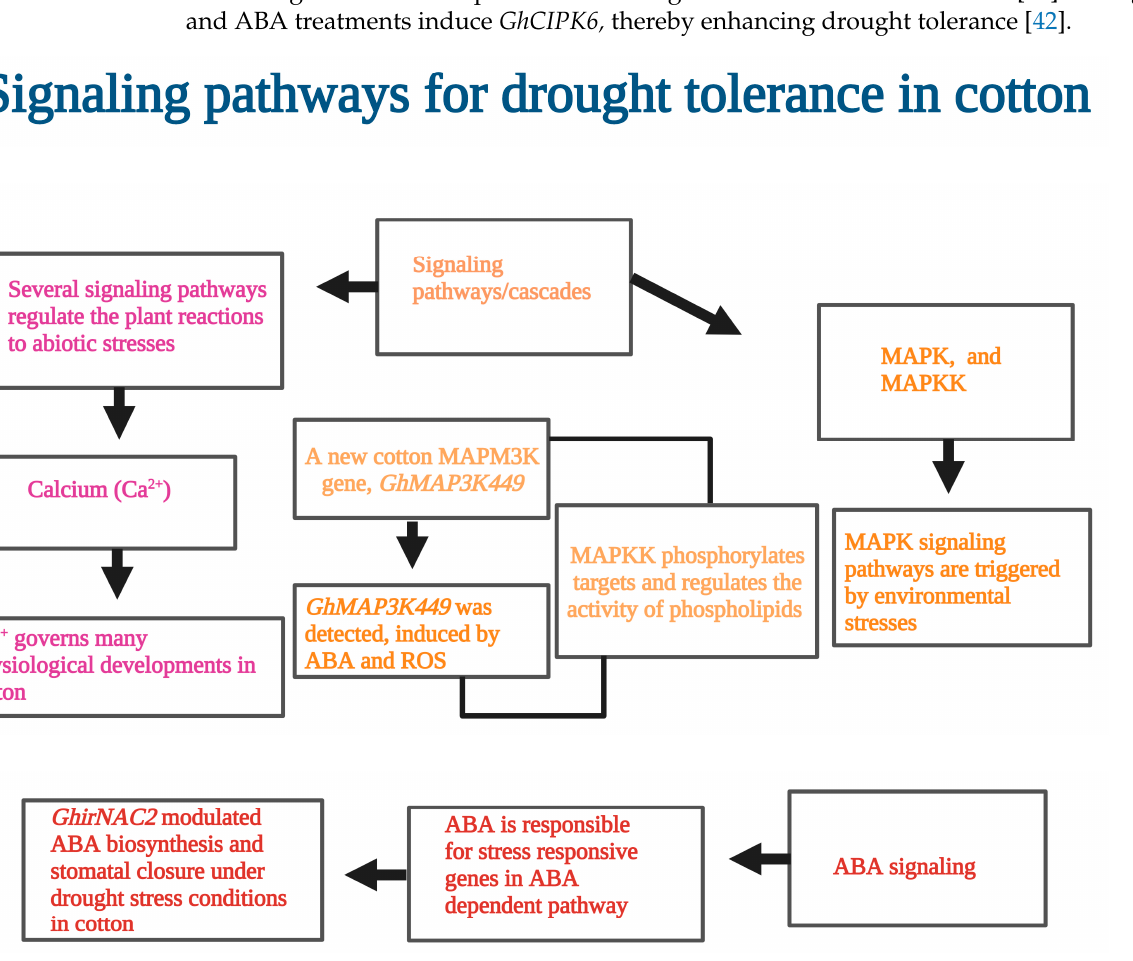
Figure 2. Drought tolerance is regulated by numerous genes and their interacting networks. MAPK, Ca 2+, and ABA signaling play an essential part in drought tolerance in cotton. This figure was made with Biorender.com.